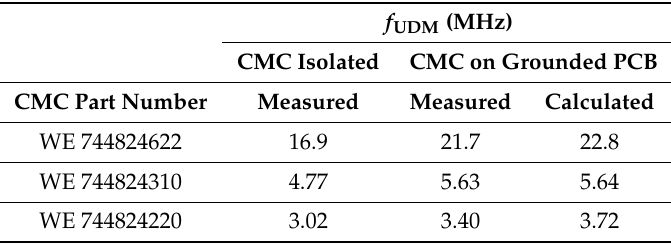
Table 4. Measured frequencies of resonance of S UDM for three CMCs when isolated and when mounted 21 on a PCB with a grounded return plane. Also, calculated f UDM for the latter case. f UDM (MHz) CMC Isolated CMC on Grounded PCB CMC Part Number Measured Measured